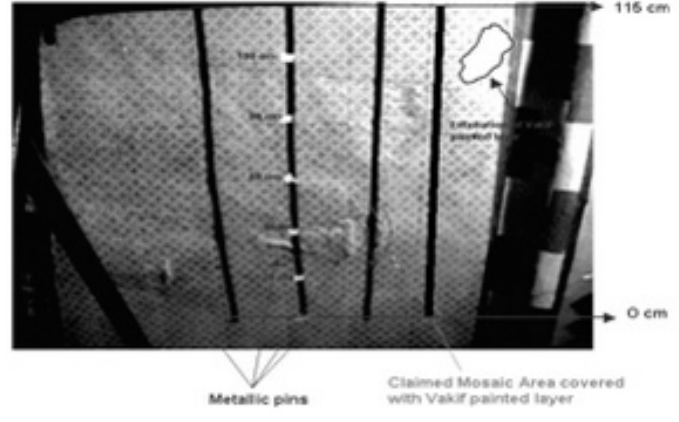
Figure 22. Photograph of investigated surface in the Hagia Sophia dome.